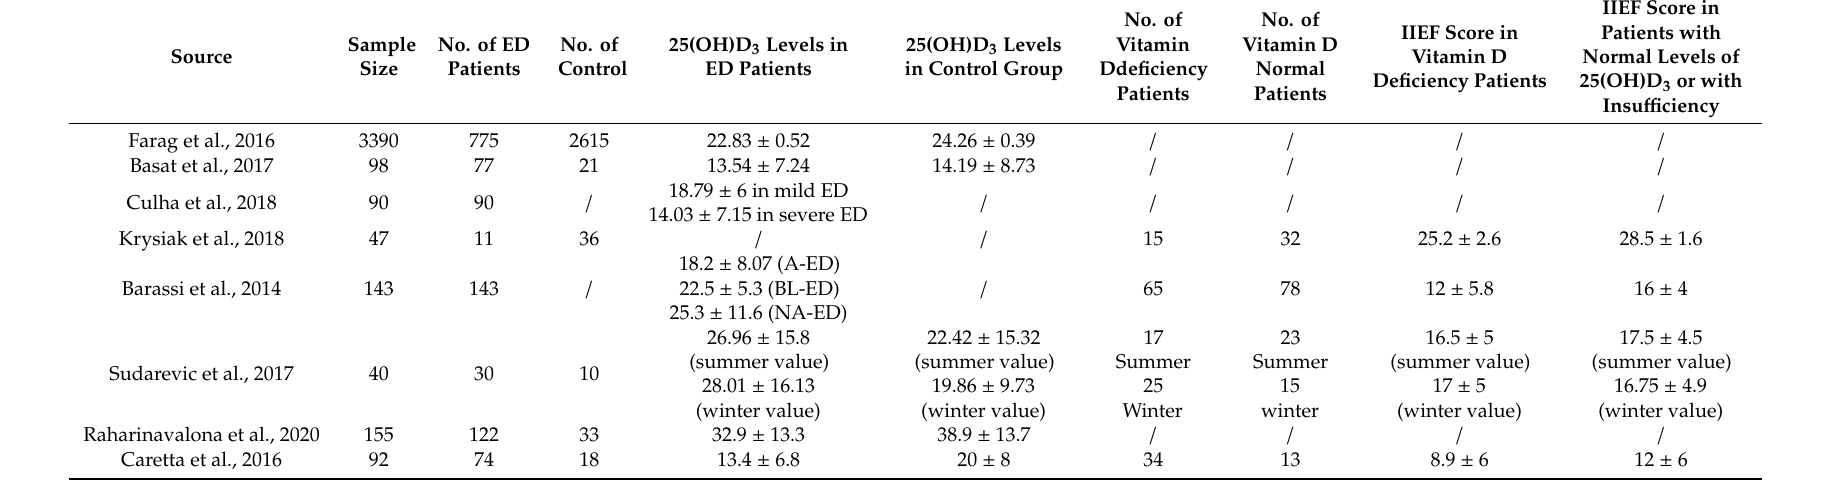
Table 1. Summary of the studies